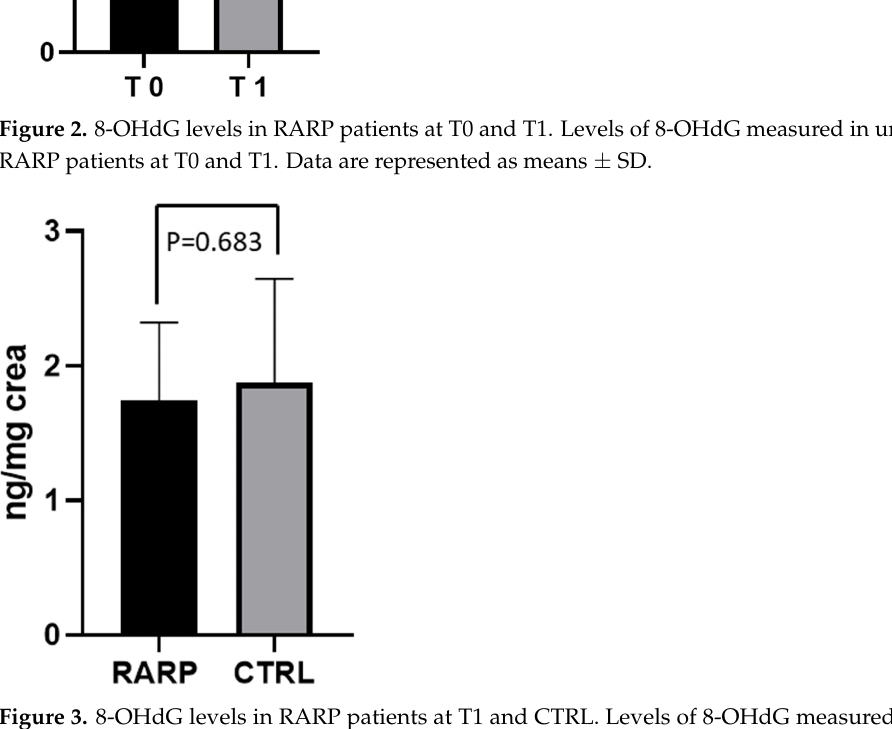
Figure 3. 8 ‐ OHdG levels in RARP patients at T1 and CTRL. Levels of 8 ‐ OHdG measured in urine from RARP patients at T1 and CTRL subjects. Data are represented as means ± SD. from RARP patients at T1 and CTRL subjects. Data are represented as means ±